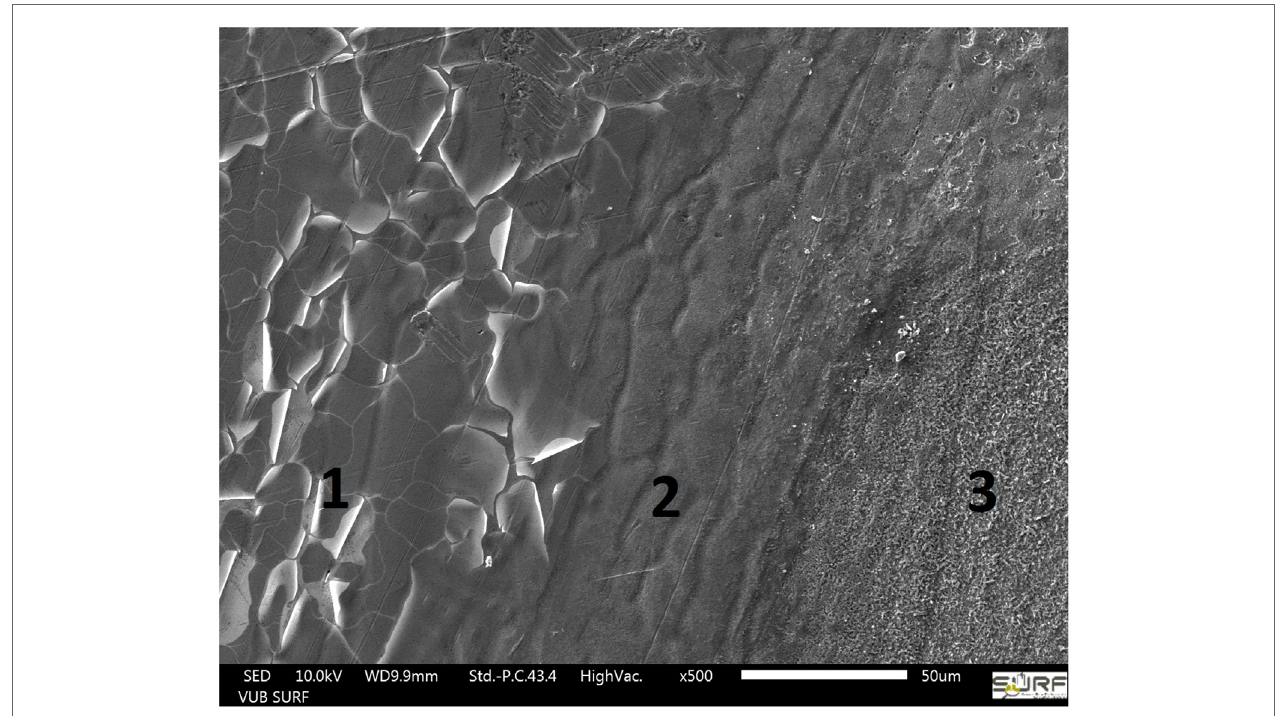
FigUre 8 | seM image of the hDg surface at the delamination front (2): left side (1) not attacked area, right side (3) corroded surface .